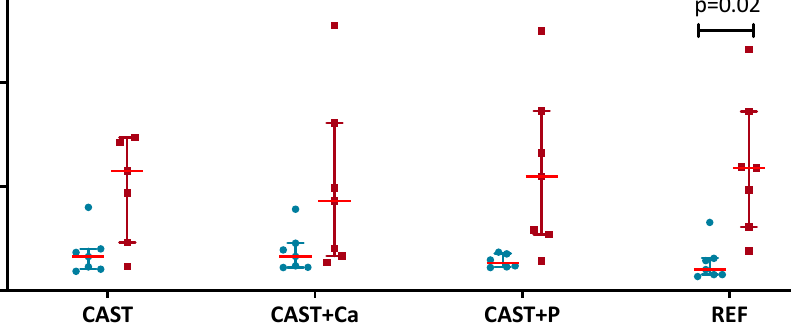
Figure 5. Cell proliferation tested by MTT-assay. Besides the comparison of reference material (REF) and cast specimens (CAST), the influence of beamline-implanted Ca- or P-ions into surfaces on cytotoxicity / proliferation was also tested. The proliferation of osteoblasts on the surfaces was investigated on day 1 and day 7 ( n = 7 each). The quotients of OD 570–650 nm were measured, and respective values are shown as scatter plots with Median and interquartile ranges. Influences of time as well as surfaces were analyzed by two-way ANOVA and Bonferroni post hoc tests for statistical significance. The significance level was set to p ≤ 0.05. OD: Optical Density; Ca: Ca-ion; P: P-ion; Implantation dose 1 × 10 − 16 cm 2 , implantation energy 30 keV.